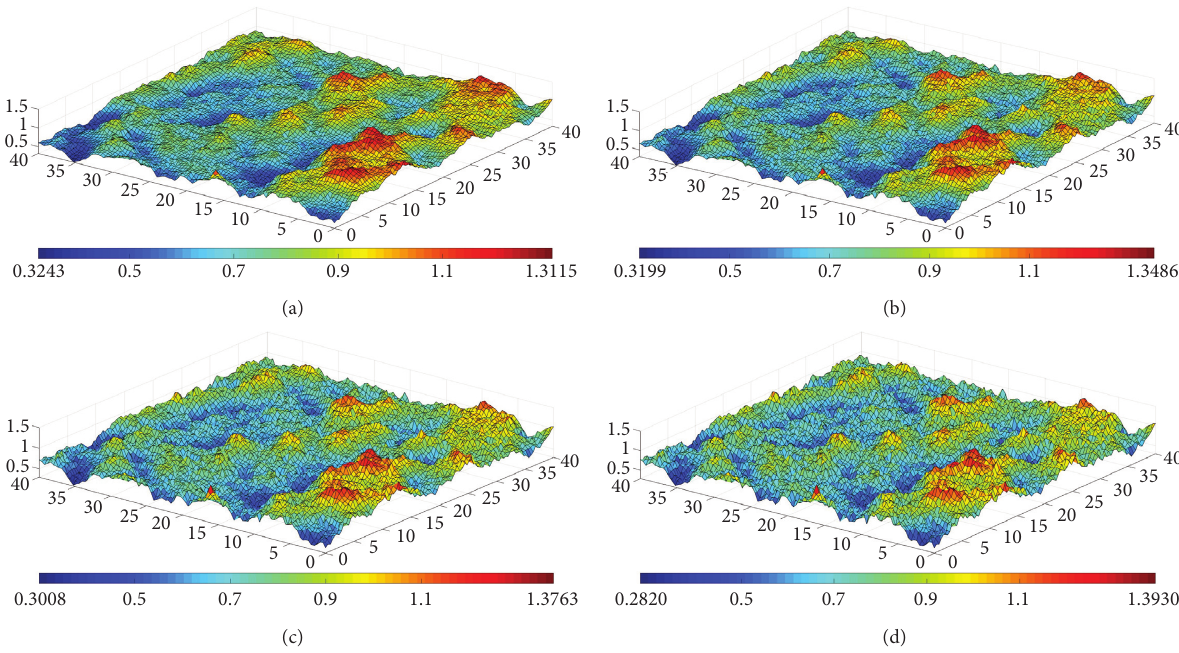
Figure 2: Comparison of the morphology of fracture models for δ � 0.15 mm (red represents large aperture; blue represents small aperture; unit: mm). (a) D � 2.1. (b) D � 2.2. (c) D � 2.3. (d) D �